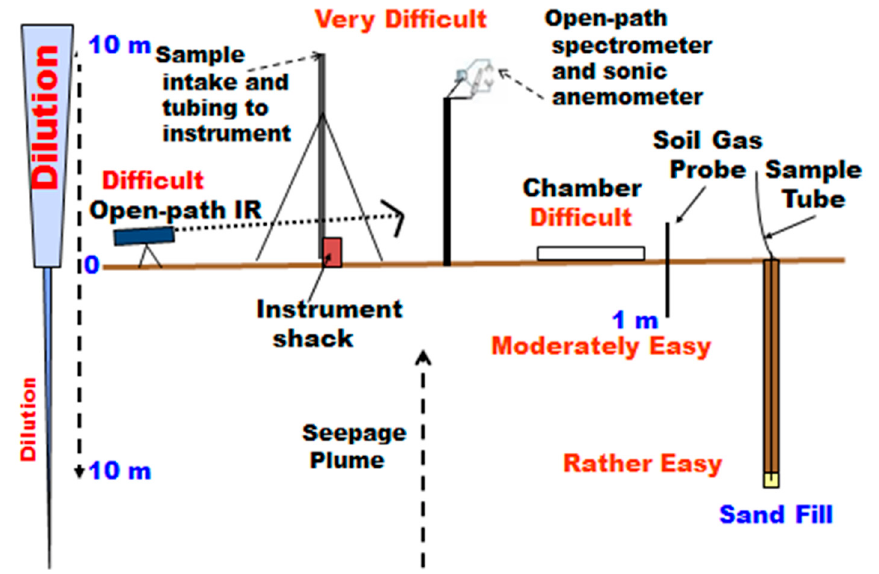
Figure 2. Schematic of gas measurements at different elevations above and below the land s urface (modified from Klusman [19]). (modified from Klusman